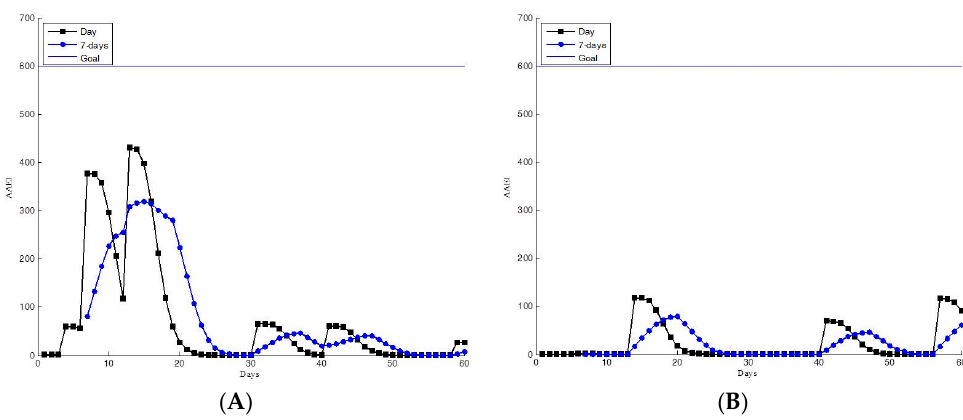
Figure 11. Participants with inactive AAEI values, as determined in the 60-day trial. ( A , B ) Low AAEI values indicating infrequent exercise.